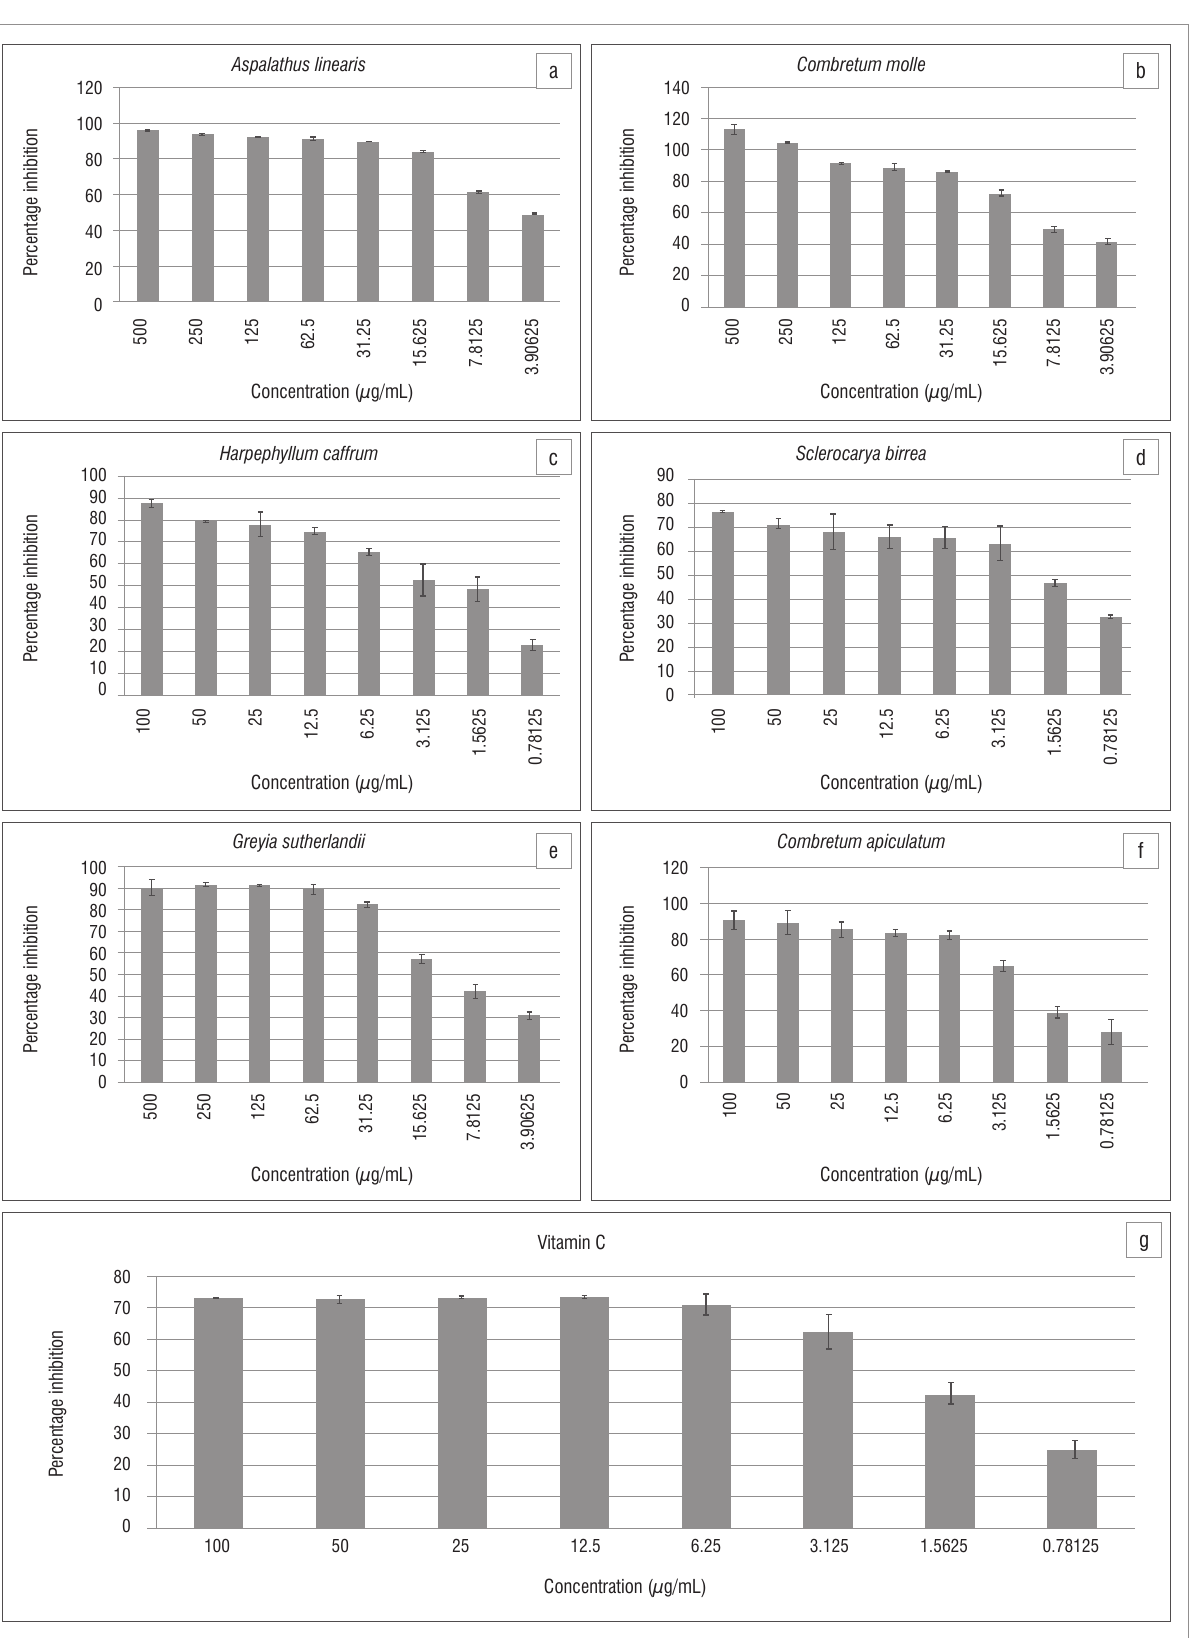
Figure 1: The DPPH radical scavenging activity of the potential extracts and the positive control (vitamin C): (a) Aspalathus linearis (EC =3.5±0.5 µg/mL), (b) Combretum molle (EC 50 birrea (EC =2.06±0.03 µg/mL), (e) Greyia sutherlandii (EC 50 (g) vitamin C (EC =1.98±0.005 50